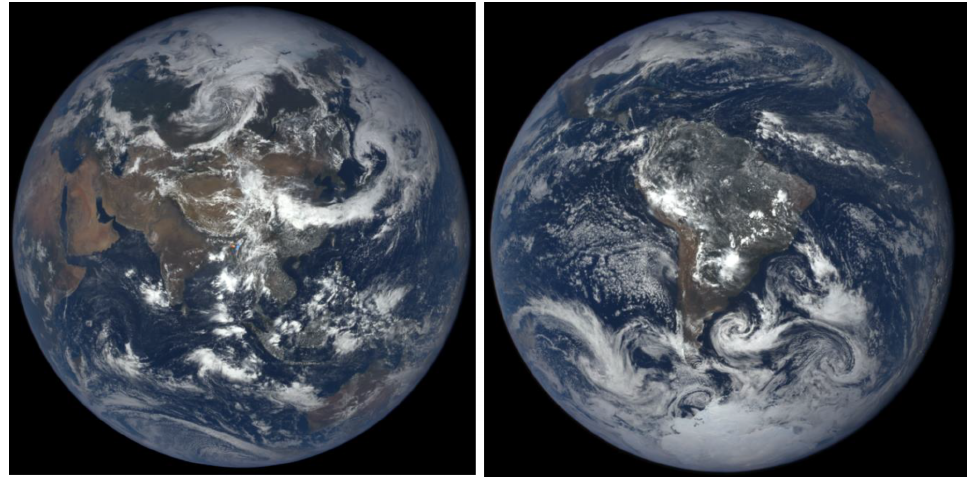
Figure 3. Natural-color EPIC earth images from 6 June and 6 December 2016 showing the field of view during the respective hemispheric summers. In both of these images, 6 months apart, the EPIC orbit is to the west of the earth–sun line, causing the west side of the globe (sunrise) to appear brighter than the east side (sunset). Notice the bright specular reflection over Argentina, South America, embedded within a cloud feature. This is thought to be from ice crystals in high clouds (Marshak et al.,